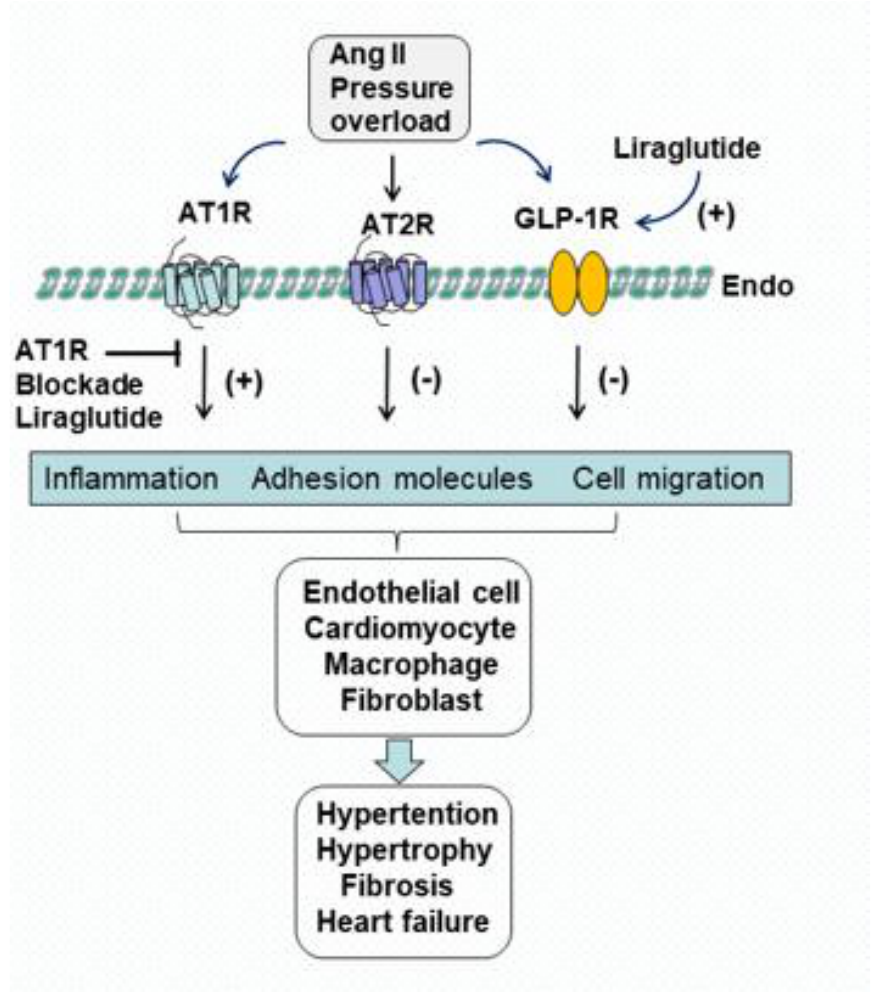
Figure 2. The signaling pathways involved in cardiovascular regulation under activation of the two Ang II receptor subtypes, AT1 and AT2 receptor (AT1R and AT2R) as well as GLP-1 receptor (GLP-1R). Ang II infusion or pressure overload elicits inflammatory responses, upregulates adhesion molecular expression on the vascular endothelium (Endo) and promotes extravascular cell migration by stimulating AT1R (+), further resulting in hypertension, cardiac hypertrophy, fibrosis and heart failure. There is functional cross-talk between AT1R and AT2R in these signaling pathways. Moreover, the activation of the AT2R causes vasodilatory, anti-inflammatory, antiproliferative and antifibrotic effects by eliminating the AT1R-mediated responses ( − ), evidenced by reduced hypertension and improved cardiac function. The GLP-1R agonist liraglutide activates GLP-1R (+), and protects the cardiovascular system, yielding beneficial effects as compared to blockade of AT1R (-), suggesting that the protection is potentially mediated by inhibiting AT1R via GLP-1R. Endo: